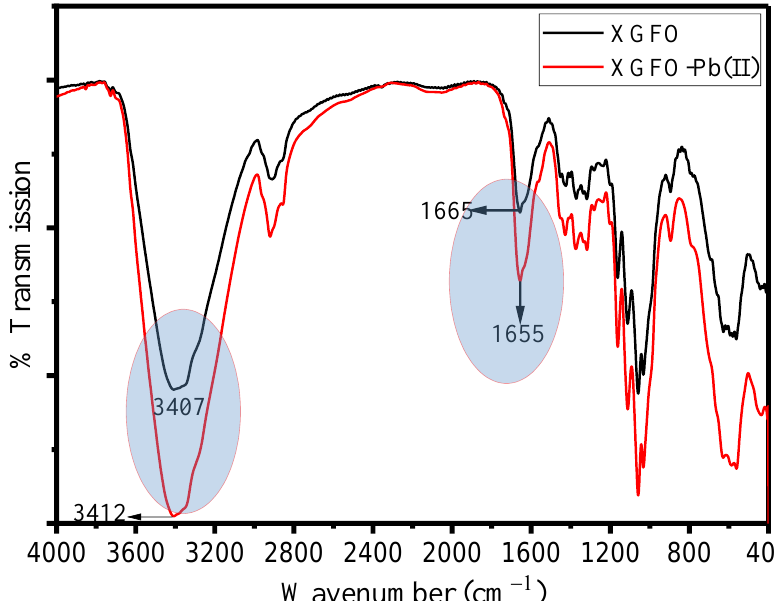
Figure 10. FTIR spectra of XGFO before and after adsorption of Pb (II).